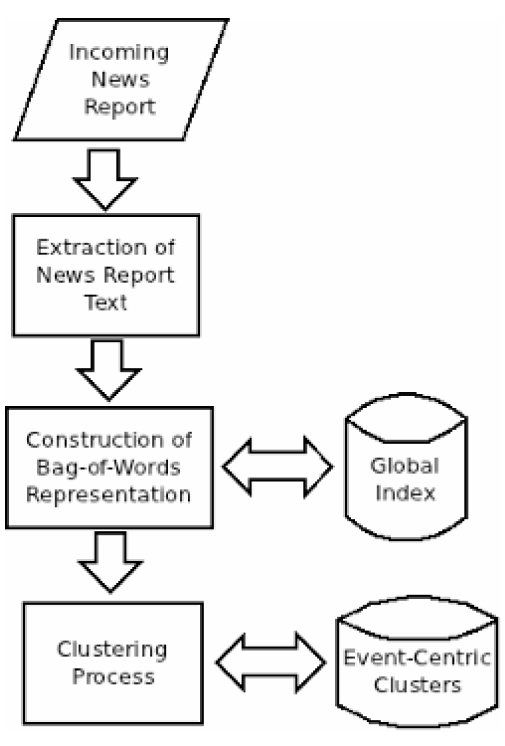
Figure 1. The Categorisation